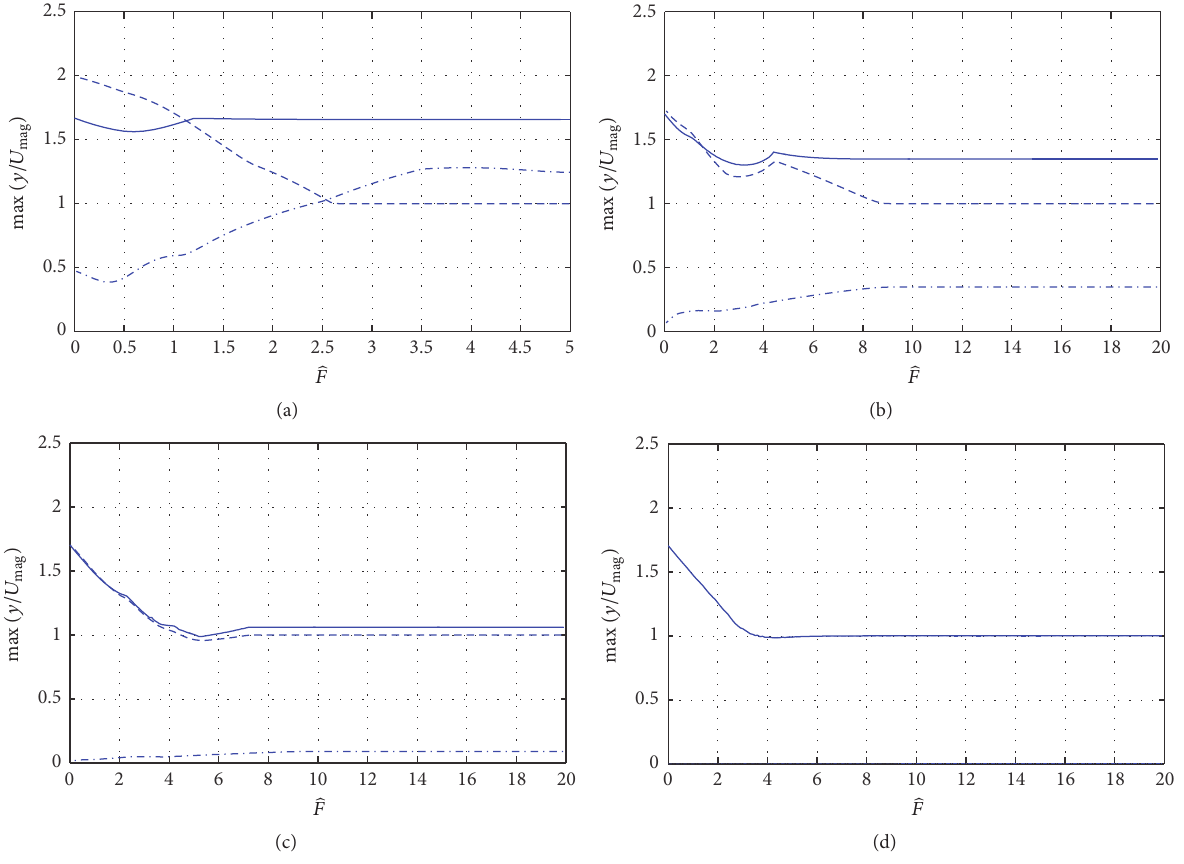
Figure 5: The maximum displacement response of the two masses in the friction system under a versed sine base input for different levels of friction. The solid line is the primary mass displacement and the dashed line is the secondary mass displacement. The dash-dotted line is the relative displacement, mass ratio 𝜇 = 0.1 , pulse length 𝑇 𝑝 = 𝑇 1 , nondimensional base input magnitude 𝑈 ̂𝑘 = 0.4 ̂𝑘 = 2.5 ̂𝑘 = 10 ̂𝑘 = 250 , (b) , (c) , and (d)